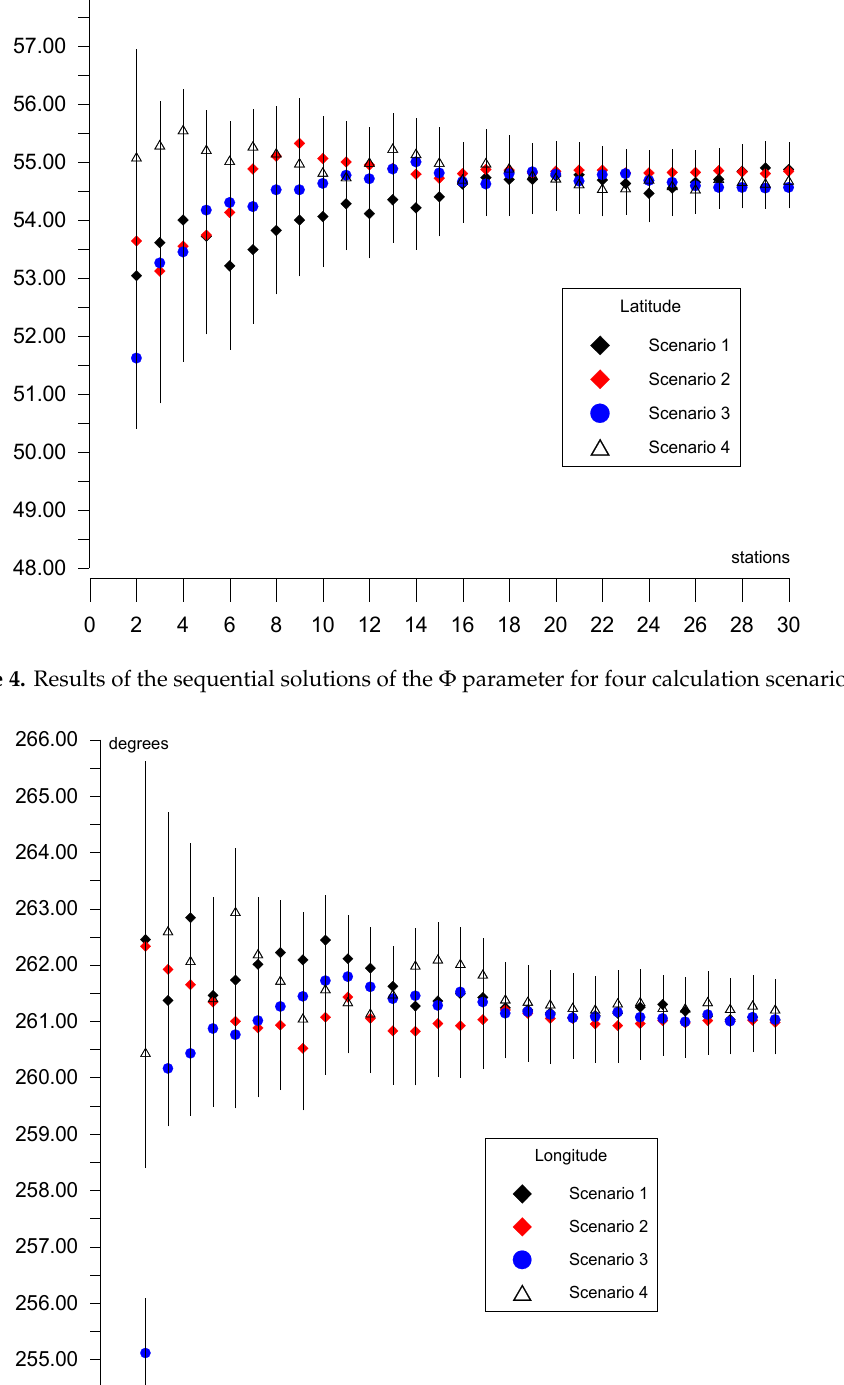
Figure 6. Results of the sequential solutions of the ω parameter for four calculation scenarios.